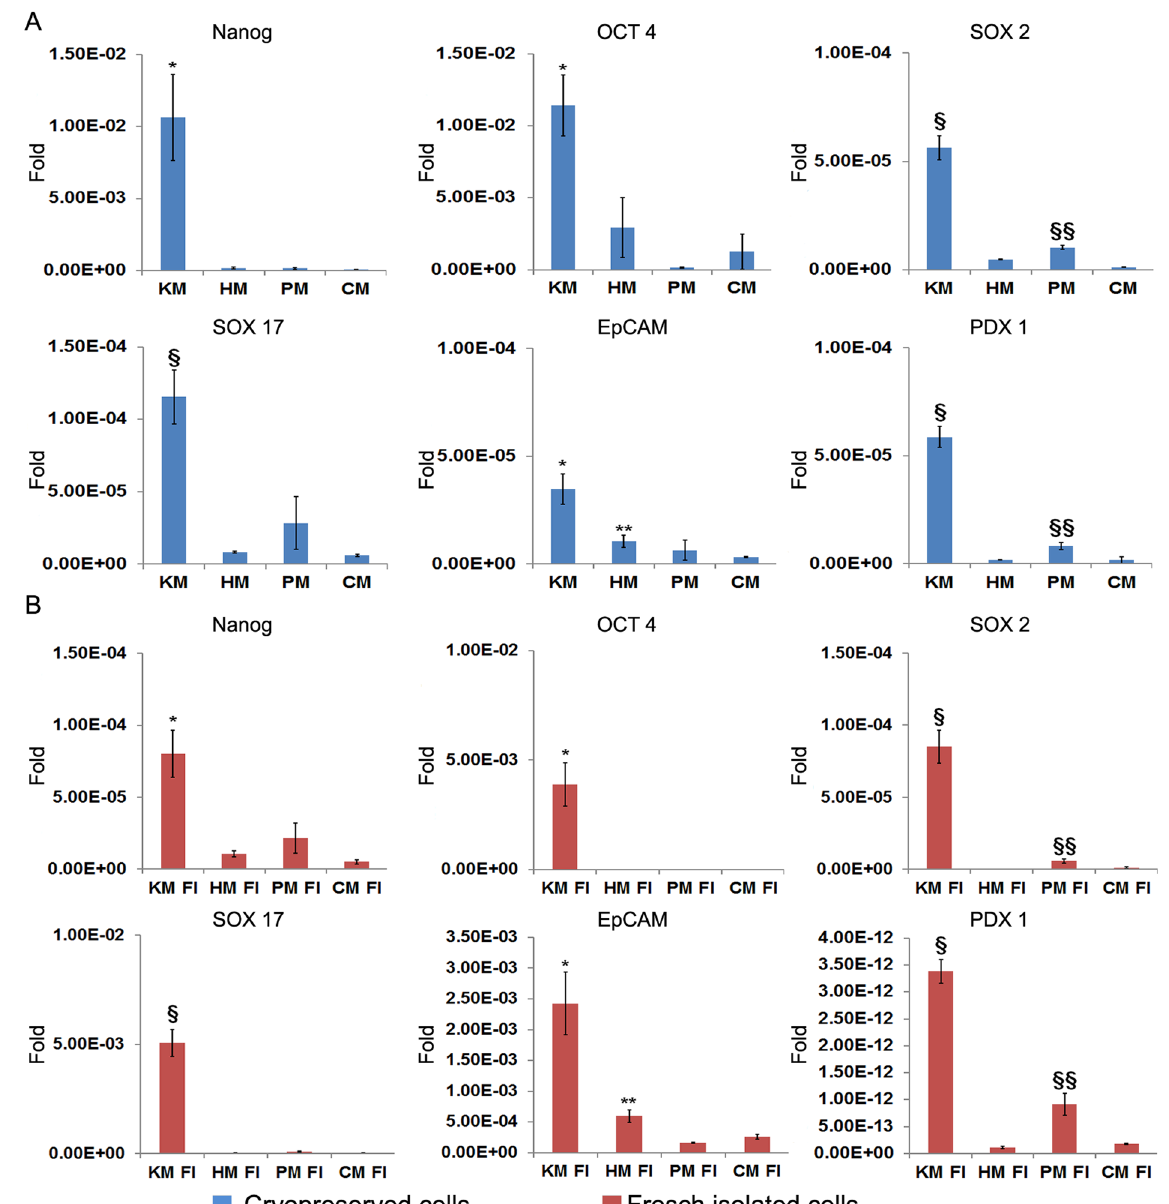
Figure 3. Expression of pluripotency and multipotency genes in cultures of cryopreserved or freshly isolated hBTSCs under self-renewal (KM) or hormonally defined medium for multiple endodermal mature fates (hepatocytic/HM, cholangiocytic/CM, pancreatic islets/PM). ( A ) Relative gene expression of SOX2, EpCAM, OCT4, PDX1, SOX17, SOX2 in cryopreserved hBTSCs in Sol1 and in Sol3 (not shown) under different culture conditions. Previously cryopreserved hBTSCs cultured under self-renewal conditions in Kubota’s Medium (KM) reduced the expression of pluripotency and multipotency genes when transferred in hormonally defined medium for particular endodermal mature fates (hepatocytic/HM, cholangiocytic/CM, pancreatic islets/ PM). Data are expressed as mean ± SD of 3 experiments; * p < 0.05; § p < 0.01; ** p < 0.05 HM vs CM and PM; §§ p < 0.05 PM vs CM and HM. ( B ) Relative gene expression of Nanog, SOX2, EpCAM, OCT4, PDX1, SOX17, SOX2 in freshly isolated (FI) hBTSCs cultured in different defined conditions. Freshly isolated hBTSCs cultured under self-renewal conditions in Kubota’s Medium (KM) reduced the expression of pluripotency and multipotency genes when transferred in hormonally defined medium for particular endodermal mature fates (hepatocytic/HM, cholangiocytic/CM, pancreatic islets/PM). Data are expressed as mean ± SD of3 experiments; * p < 0.05; § p < 0.01 ** p < 0.05 HM vs CM and PM; §§ p < 0.05 PM vs CM and